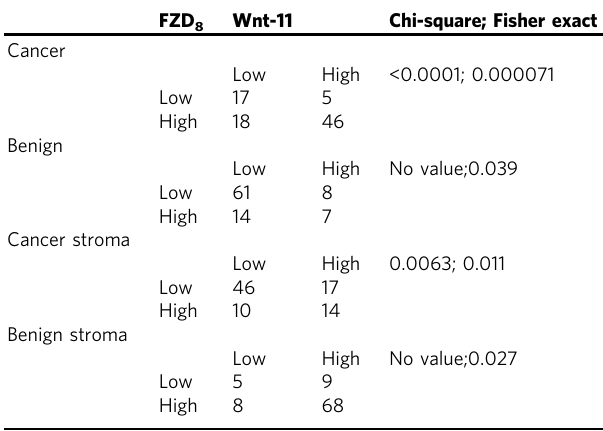
Table 3 Correlation analysis of FZD 8 and Wnt-11 expression FZD 8 Wnt-11 Chi-square; Fisher exact